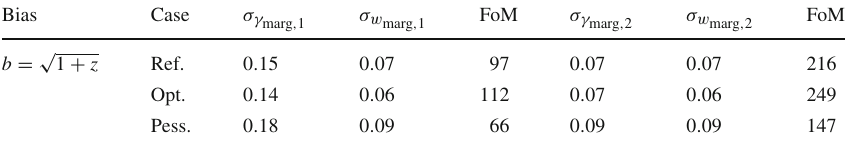
Table 8 1 σ marginalized errors for parameters γ and w expressed through γ and η parameterizations